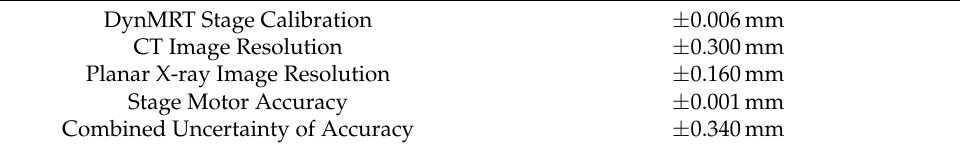
Table 1. Sources of positional accuracy contributing to the limiting accuracy of the alignment